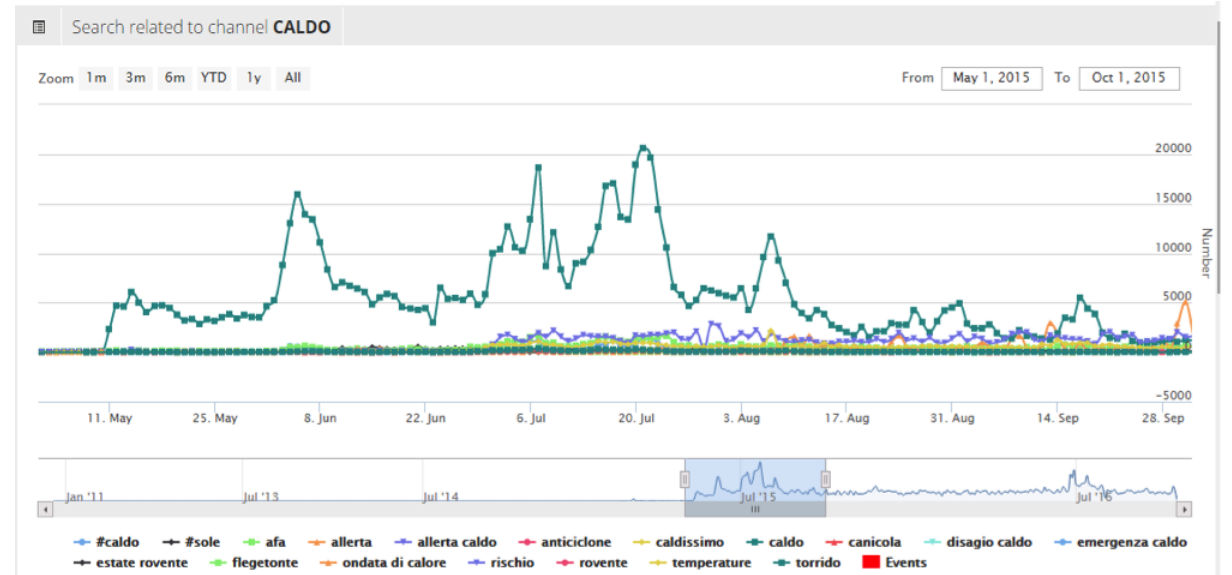
Figure 1. Daily volumes of tweets collected by TwitterVigilance in the channel “Heat” (caldo) during May–September